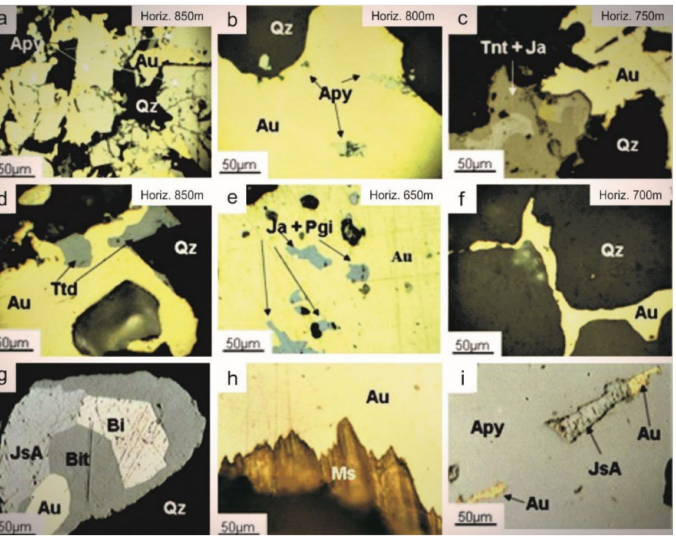
Figure 6. Intergrowths of native gold typical for gold–quartz veins GIT: ( a – f ) for different horizons of the Shkolnoye deposit: ( a ) native gold in the intergranular space of arsenopyrite, ( b ) in quartz with inclusions of small grains of arsenopyrite, ( c ) intergrowth with tennantite and jamesonite in quartz, ( d ) intergrowth with tetrahedrite in quartz, ( e ) inclusions in native gold of jamsonite and plagionite, ( f ) gold in the intergranular space of quartz; ( g ) (Maltan) inclusion of native gold in an intergrowth of bismuth, bismuthine, and joseite A; ( h ) (Dorozhnoye) intergrowth of native gold with muscovite; ( i ) (Butarnoye) small segregations of native gold in arsenopyrite intergrown with joseite